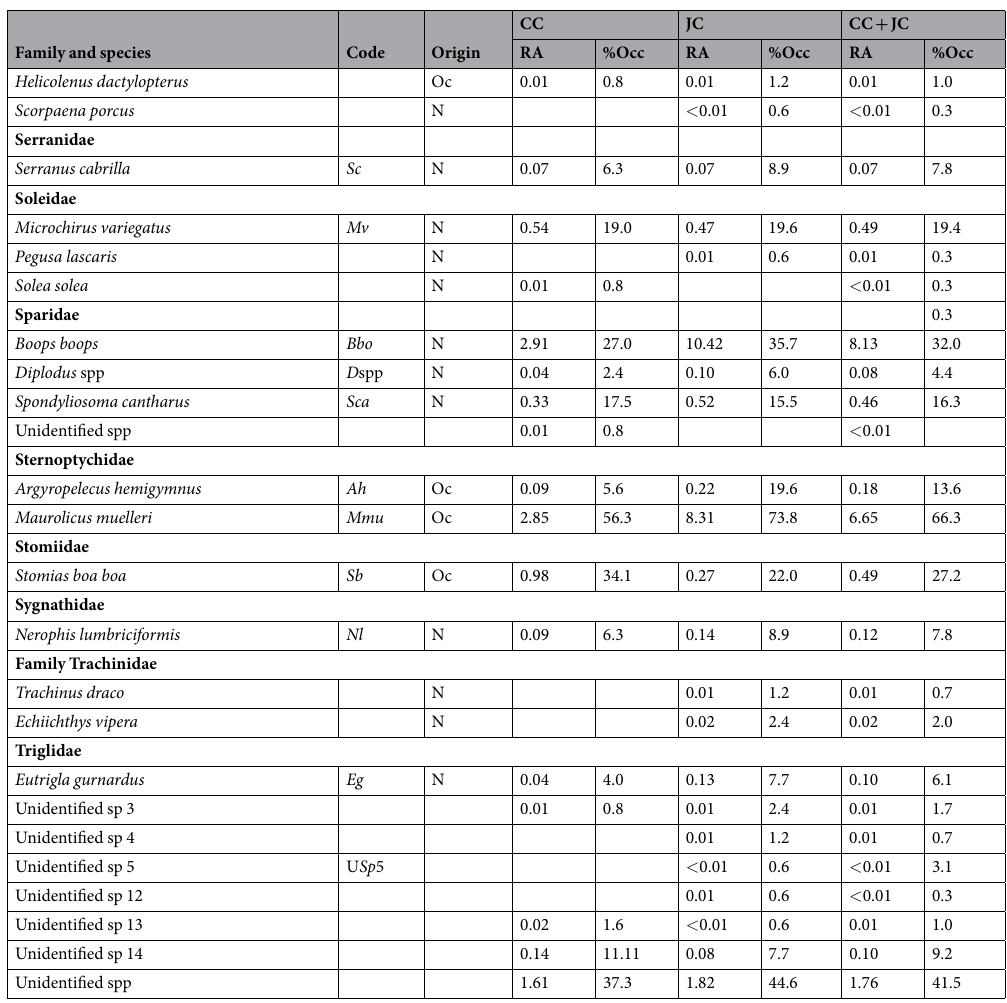
Table 2. Alphabetical list of larval fish families collected during the CAREVA 0310 (CC). The JUREVA 0410 (JC) and both cruises combined (CC + JC); Code: canonical correspondence analysis (CCA) taxon code; Origin